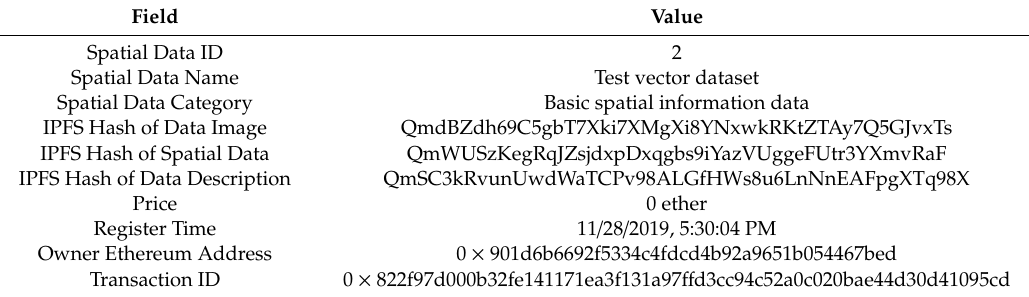
Figure 5. Copyright registration interface. Table 5. Copyright information for sample data.